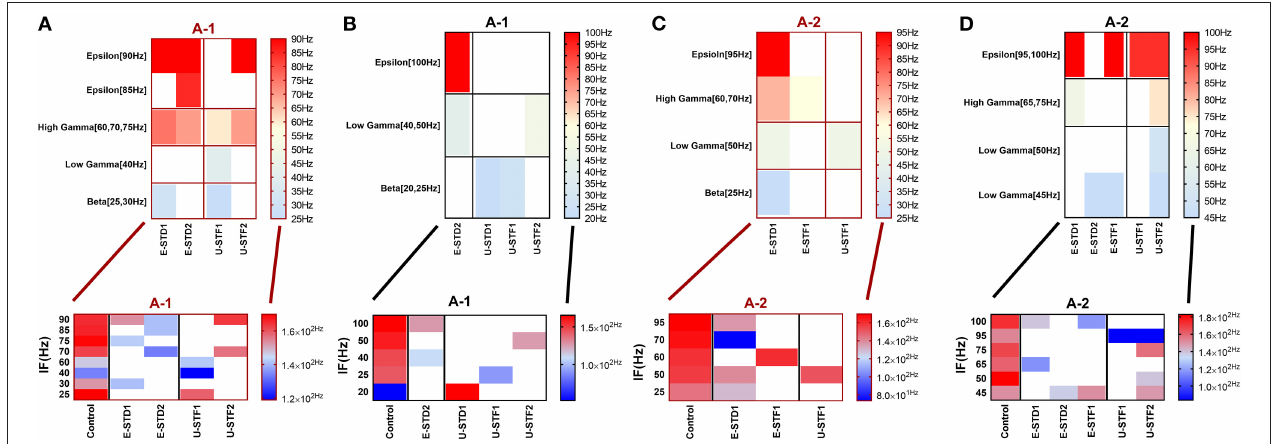
FIGURE 2 | Heat maps of selected elicited responses in each network scenario (A-1) and (A-2), in immature and mature conditions, respectively, before and after implementing dynamical synapses. (A,C) refer to immature conditions of network scenarios (A-1 and A-2) while (B,D) relate to mature conditions of network scenarios (A-1 and A-2). The upper graphs refer to particular Poisson input frequencies [IF (Hz)] that triggered a substantial modulation effect, measured in Hz before and after STP in these networks (Lower graphs). White blocks refer to excluded values due to statistical variations in probability density function (PDF). Control refers to the condition without STP implementation (dynamical synapses); STD1 and STD2 refer to two types of depressing synapses while STF1 and STF2 refer to facilitating synapse. E-STD1, E-STD1, E-STF1, and E-STF2 relate to the expected modulation effect induced by dynamical synapses i.e., reduction of firing rate activities in response to depressing synapses (STD1 and STD2) while increasing the firing rate activity in response to facilitating synapses (STF1 and STF2). On the other hand, U-STD1, U-STD1, U-STF1, and U-STF2 relate to the expected modulation effect induced by dynamical synapses, i.e., an increase of firing rate activity in response to depressing synapses (STD1 and STD2), while reduction in the firing rate activity in response to facilitating synapses (STF1 and STF2), see also Tables 5 , 6 .